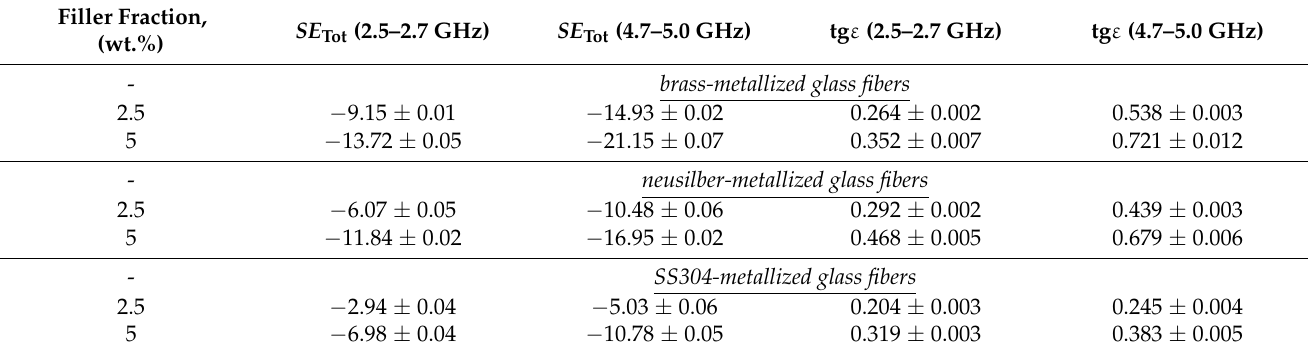
Table 2. Average characteristics of electromagnetic shielding efficiency ( SE ) and the value of dielectric loss tangent tg ε for samples of microwave shielding composites based on manufactured metallized glass fiber for 4G and 5G mobile communication bands.